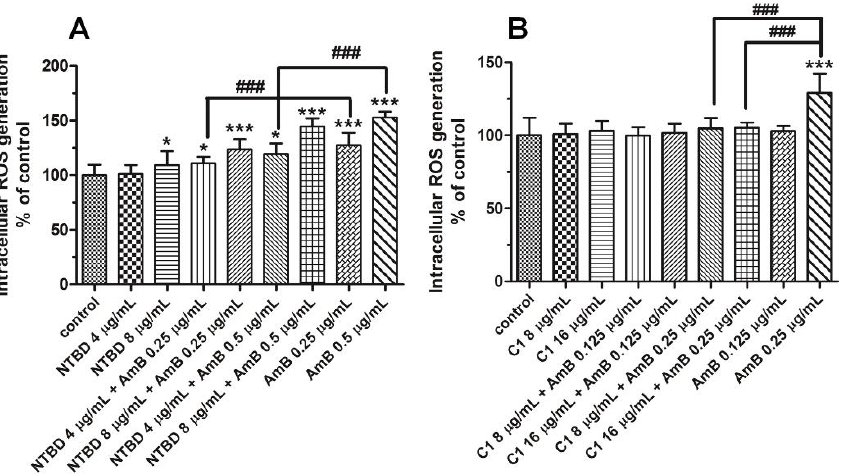
Figure 5. The impact of the combination of AmB with thiadiazols NTBD ( A ) or C1 ( B ) on ROS production in RPTEC cells. Following the 12 h treatment with or without a mixture of AmB with C1 or NTBD, and with each of these compounds alone, the ROS content was evaluated using dihydrorhodamine-123 probe as described in Method section. Data are shown as means S.D. of three independent experiments and analyzed by one-way ANOVA, followed by Dunnett’s multiple comparisons test. ( p < 0.05 *, p < 0.001 *** vs. control, ### p < 0.001 vs. AmB).